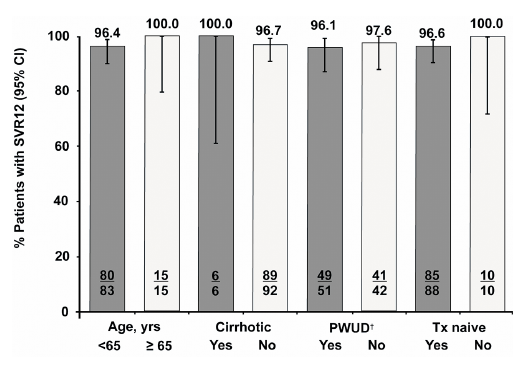
Figure 2: SVR12 rates (95% CIs as error bars) after treatment with GLE/PIB in relevant subgroups.